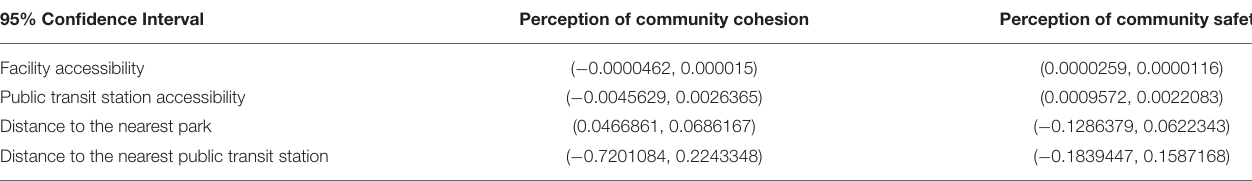
TABLE 6 | Results of the bootstrap test.